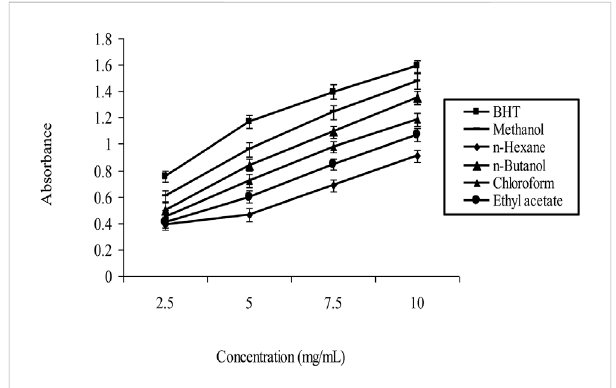
FIGURE 2 Reducing power by Amomum subulatum